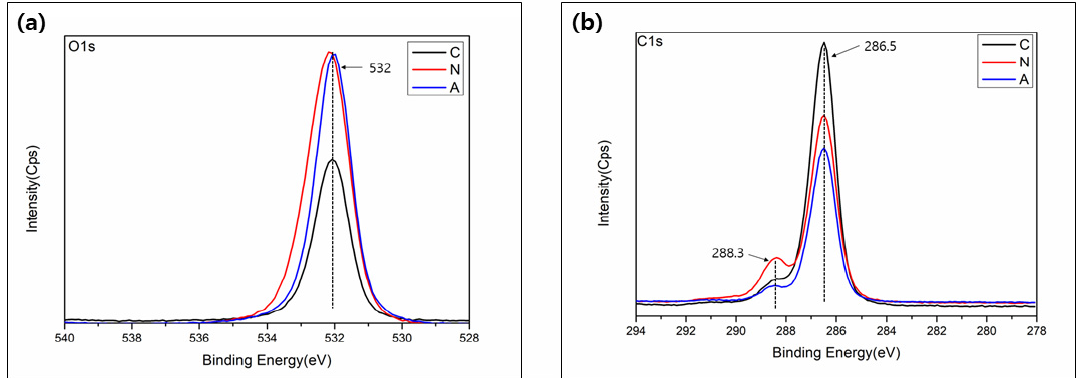
Figure 4. XPS measurement spectra on surface of specimens: ( a ) O1s and ( b ) C1s.